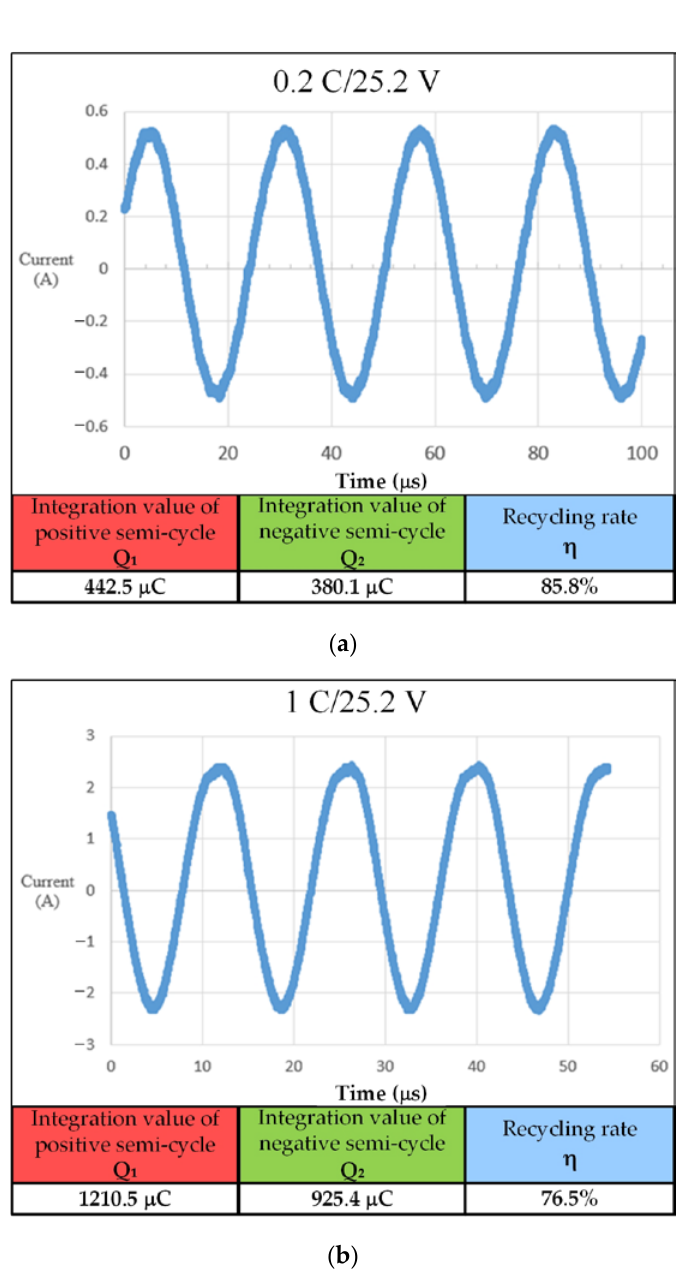
Figure 14. Calculation of energy recycling rate under various load conditions: ( a ) C rate = 0.2 C; ( b ) C rate = 1 C.